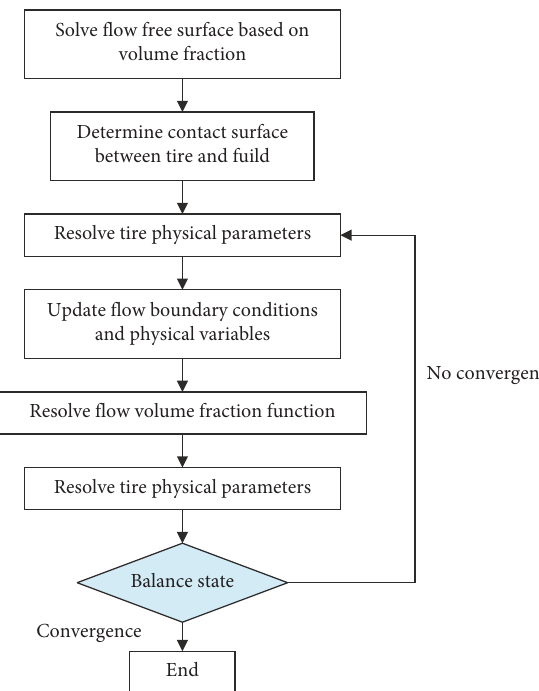
Figure 6: Contact algorithm of fluid-solid coupling